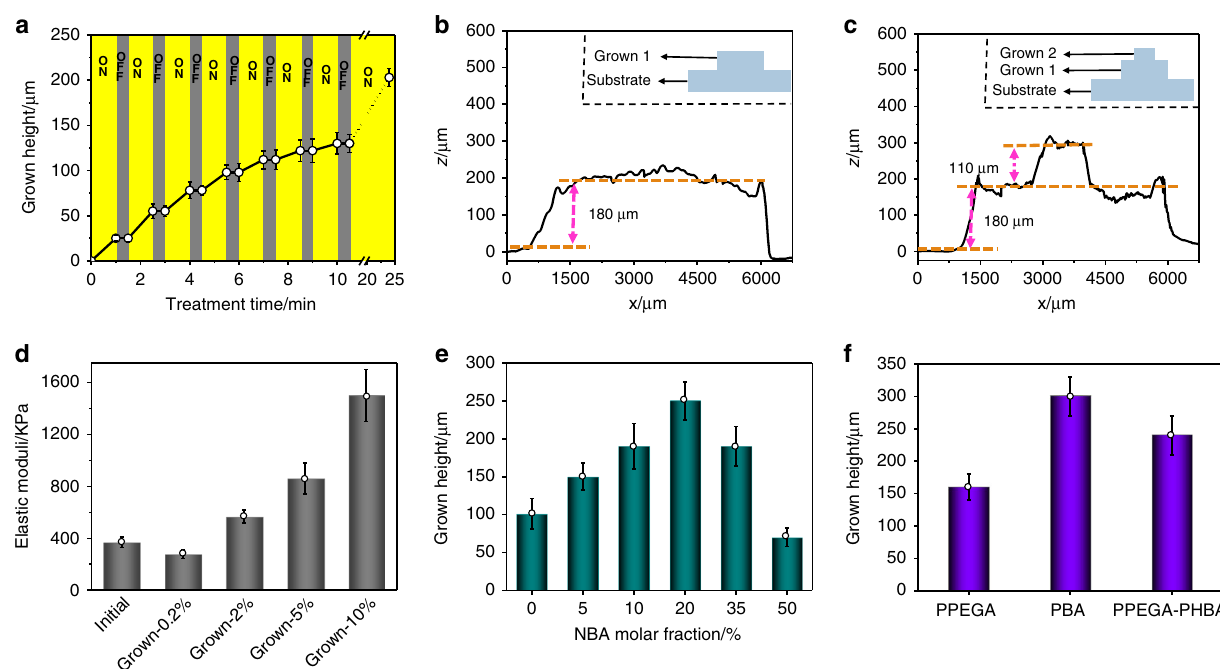
Fig. 3 Control of light-induced growth. a The height of the grown structures changes with irradiation conditions. The labels “ ON ” and “ OFF ” indicate the state of UV light applied to the samples. b The pro fi le of the grown structure obtained from fi rst-cycle growth. A round photomask with a diameter of 5000 µ m was used. c The pro fi le of the grown structure prepared from two-cycle growth. The grown sample in ( b ) was used, and it was reswelled in nutrient solution for growth. A round photomask with a diameter of 1250 µ m was used, and irradiation was selectively applied to the grown region. d Modulus of the seed and the grown structures obtained from the nutrient solution with different crosslinker concentrations ( x in Grown- x in the label). e The height of the grown structure obtained from the seed containing different NBA molar fractions. f The height of the grown structure made from different monomers. PPEGA/PBA: PEGA/BA-based seeds grew from PEGA/BA-based nutrient solution; PPEGA-PHBA: PEGA-based seeds grew from HBA-based nutrient solution. Seed-20% was used in ( a ), ( b ), ( d ), and ( f ), and the data in ( a ), ( d ), ( e ), and ( f ) were obtained from three independent measurements. Error bars are s.e.m. The height values in ( e ) and ( f ) were collected at plateau